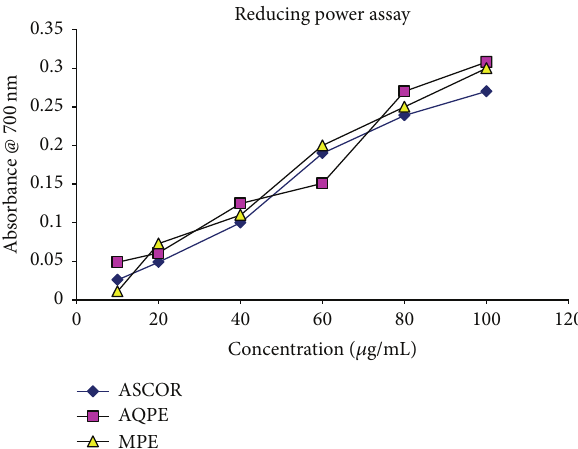
Figure 1: The effect of different concentrations of P. granatum peel extracts and ascorbic acid (ASCOR) reducing power assay. Values are means ± SE of analyses done in triplicate. ∗ Concentration of extracts in increasing order: 10, 20, 40, 60, 80, and 100 𝜇 g/mL; concentration of ascorbic acid in increasing order: 0.005, 0.01, 0.02, 0.03, 0.04, and 0.05 𝜇 g/mL.